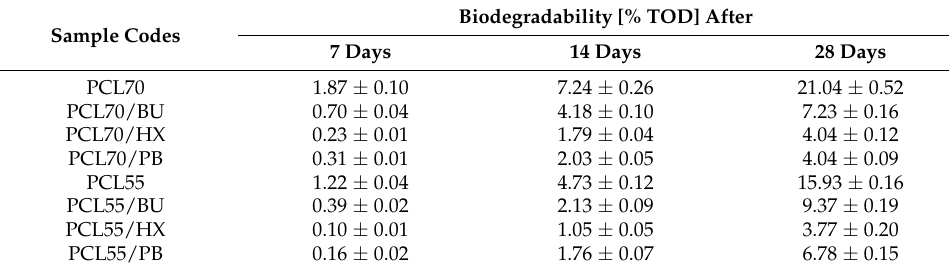
Table 5. The results of the biodegradation of PCL/PLA